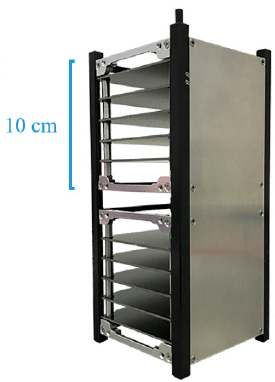
Figure 8. Structural frame of a 2U CubeSat (Credit: ISIS).